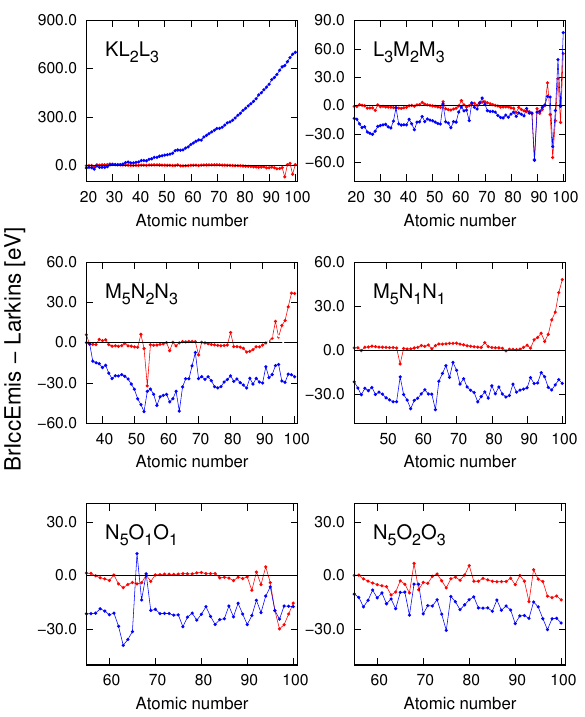
Figure 1. Auger electron energy di ff erences between BrIccEmis with (red line) and without (blue line) energy corrections to val- ues from Larkins